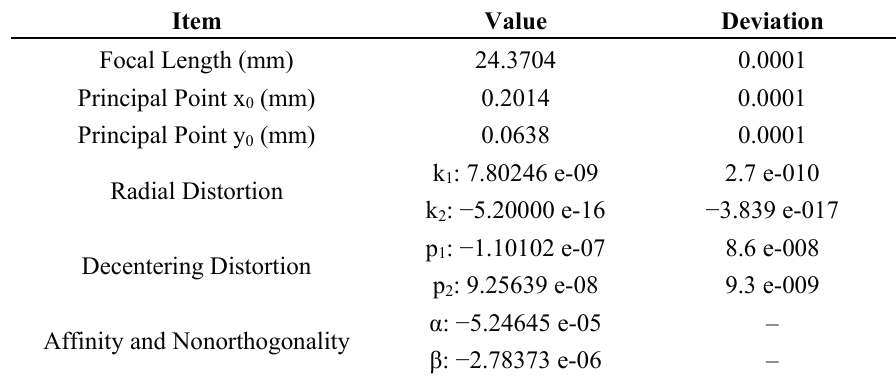
Table 4. Result of the calibrated parameters of the digital camera mounted on the